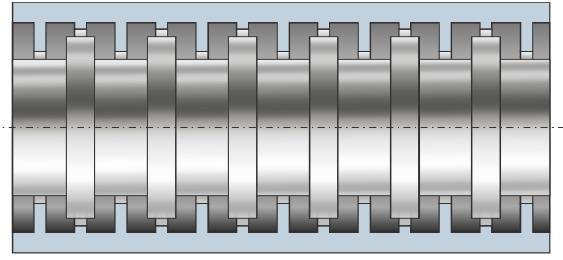
Figure 1: Schematic view of a staggered labyrinth seal.